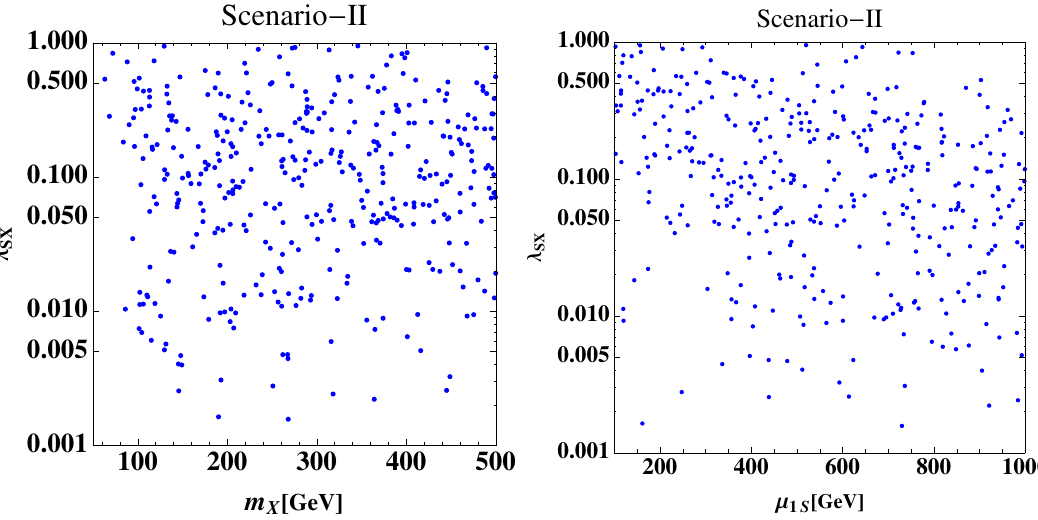
Figure 3 . Scatter plot for parameters on m X - (cid:21) SX and (cid:22) 1 S - (cid:21) SX planes in left and right panels under the DM relic abundance bound in Scenario-II.